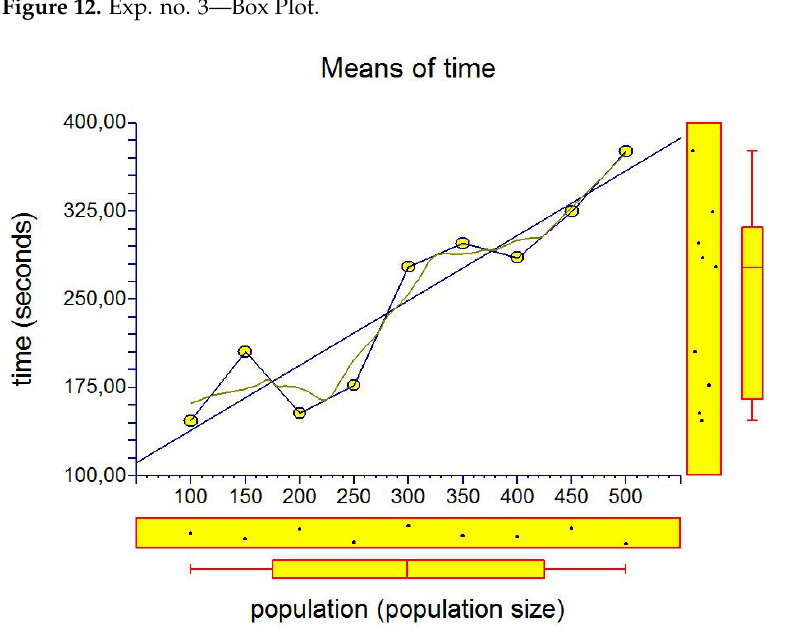
Figure 13. Exp. 3—Computing time